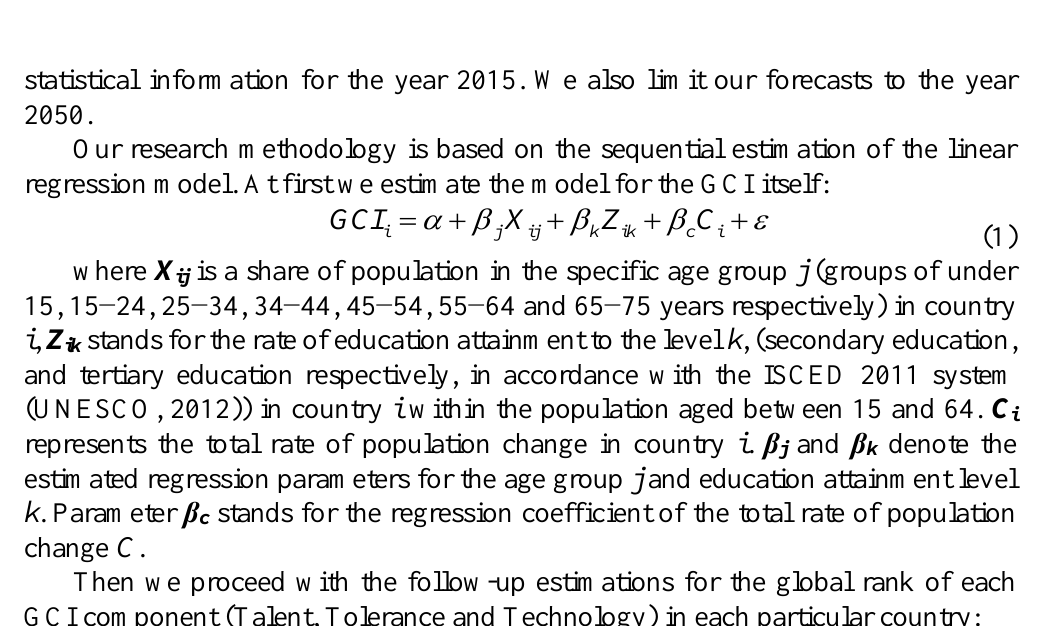
Table 1. Linear Model Estimation Results of the Impact of Selected Demographic Factors on the GCI and its Component Global Ranks in 28 EU countries in 2015 (authors’ calculations based on the Eurostat data) Technology Tolerance Parameter GCI Talent rank rank rank Population aged under 15 (%) 5.491 * −1.148 ‘